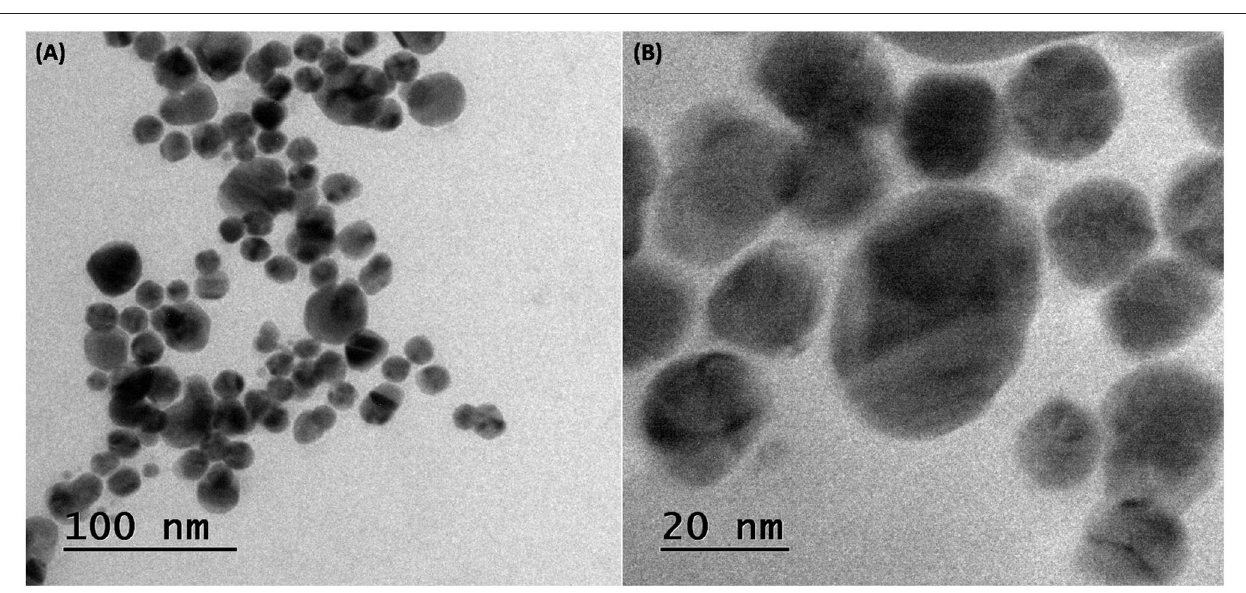
FIGURE 3 | TEM images of embelin-derived AgNP. (A) 100nm and (B)